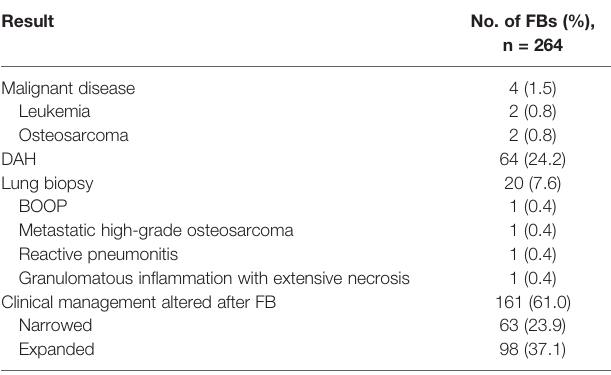
TABLE 5 | Bronchoscopy